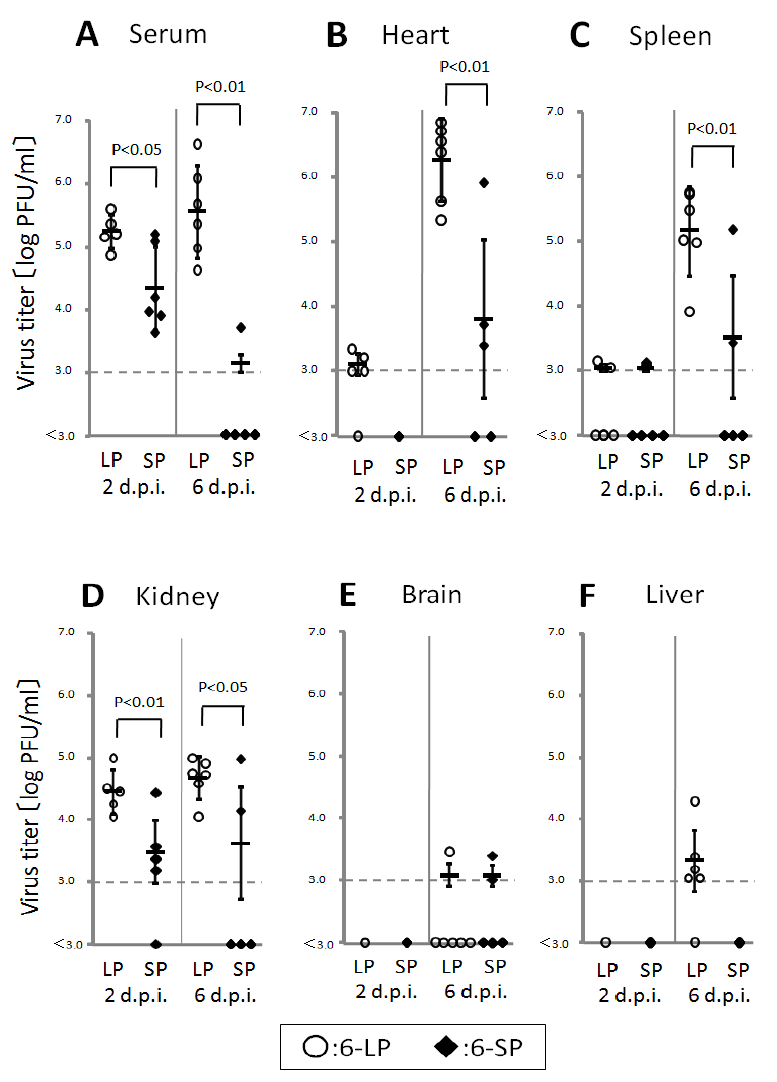
Figure 5. Viral titers in the serum ( A ), hearts ( B ), spleens ( C ), kidneys ( D ), brains ( E ), and livers ( F ) of 2-day-old chicks infected with 6-LP ( ○ ) or 6-SP ( ◆ ). Chicks were infected with 10 2 PFU subcutaneously (s.c.) in the femoral region, and blood and tissues were collected at 2 and 6 days post infection (d.p.i.). Virus titers were determined by plaque assay using BHK-21 cells (n = 5 or 6). Individual and mean PFU values are represented by symbols and bars, respectively. When mean values were calculated, the titers of samples below the detection limit (10 3 PFU/mL) were considered to be 3.0. Error bars indicate standard deviations. p -values were calculated using unpaired Student